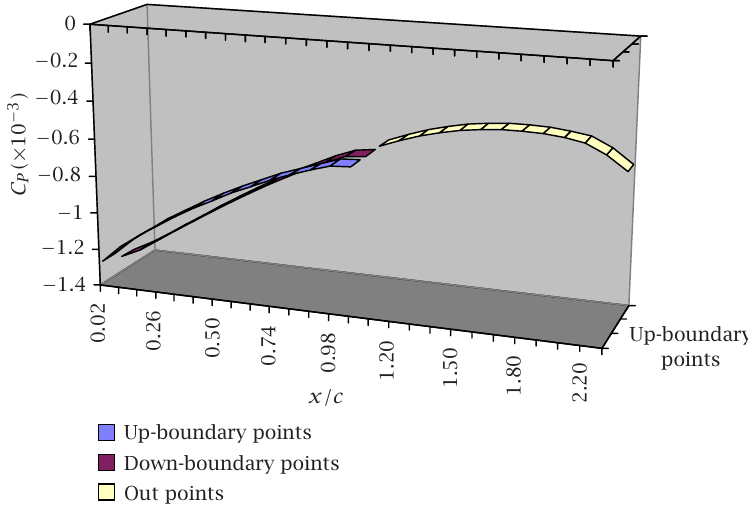
Figure 6.2 . Pressure distribution (3D form) around the aircraft of Figure 5.1, for linear vortex distribution and speed